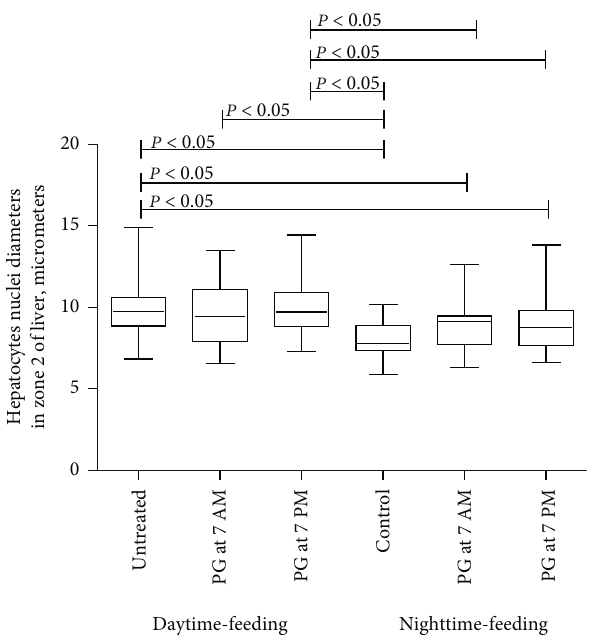
Figure 7: Comparison of the nuclear diameter of hepatocytes between the